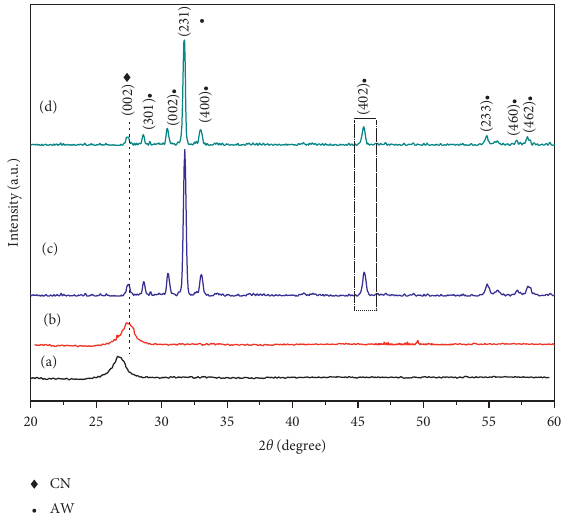
Figure 3: XRD spectra of (a) CN, (b) Fe-CN, (c) CN-AW, and (d)